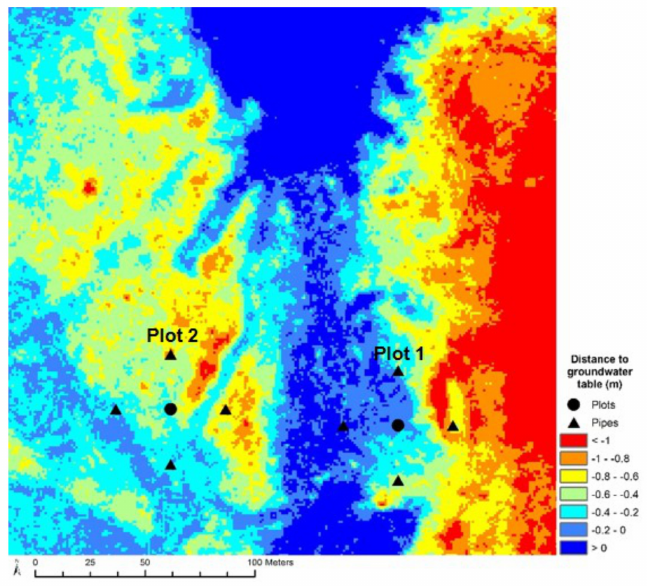
Figure 6. Average distances between the soil surface and the interpolated groundwater table for the period October 2010 to May 2013.